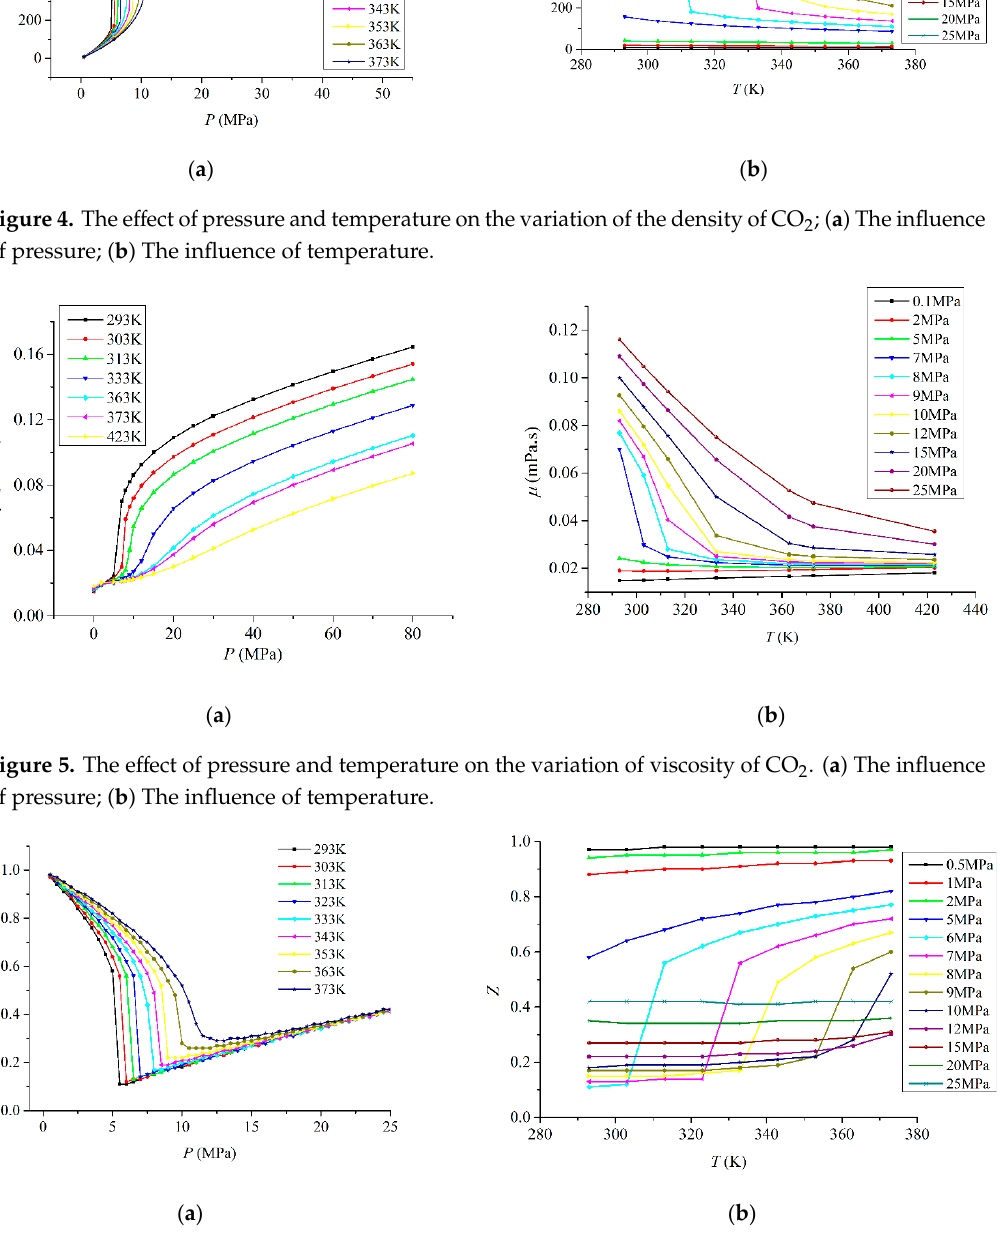
Figure 6. The effect of pressure and temperature on the variation of the compressibility coefficient of CO 2 . ( a ) The influence of pressure; ( b ) The influence of temperature.